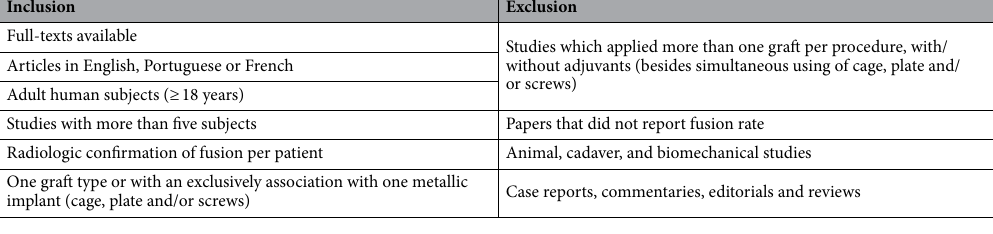
Table 1. Inclusion and exclusion